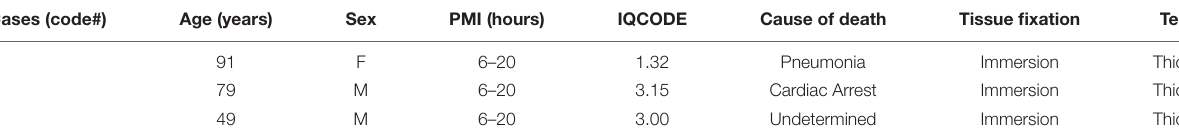
TABLE 1 | Characteristics of the human cases.